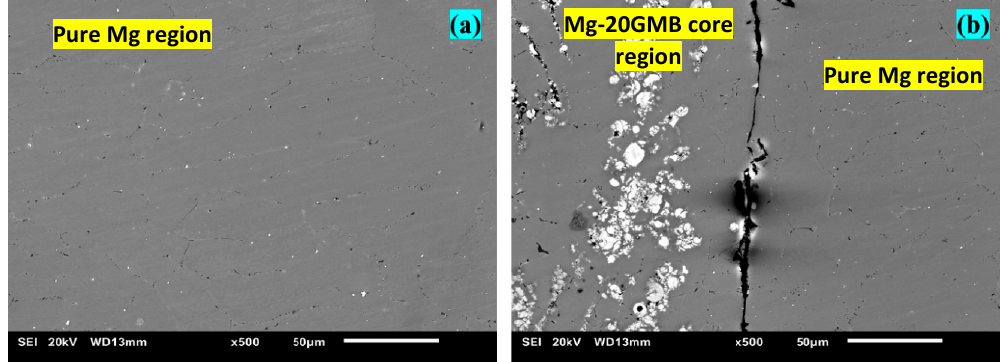
Figure 4. Scanning electron microscopy of as-cast: ( a ) pure Mg and ( b ) Mg/Mg-20GMB hybrid composite.